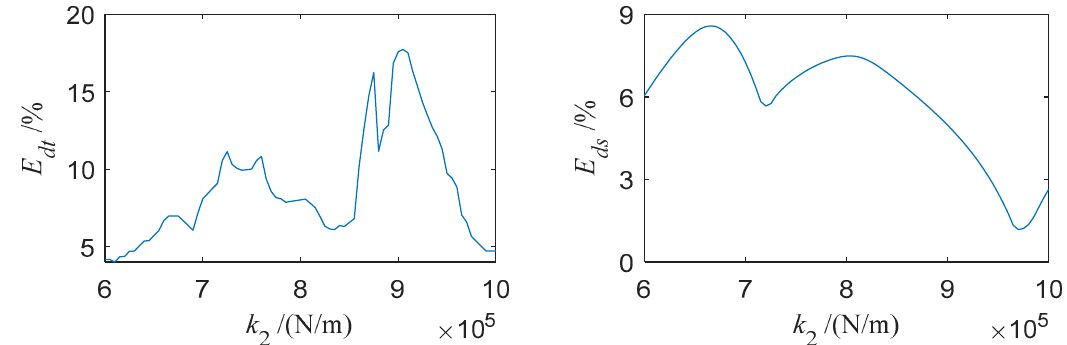
Figure 13. The influence of damper stiffness on the vibrational power reduction.